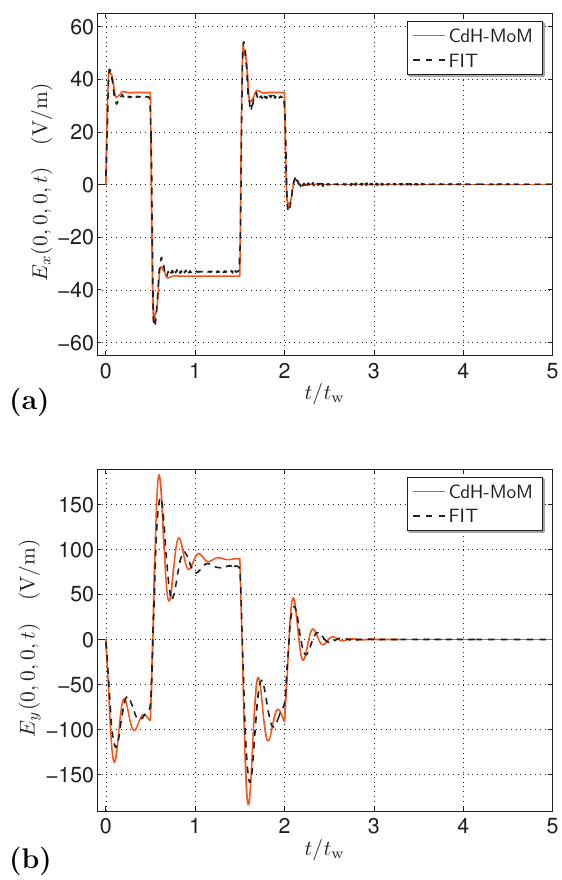
Figure 3. Electric-field pulse shapes as induced at the center of the aperture with relative dimensions